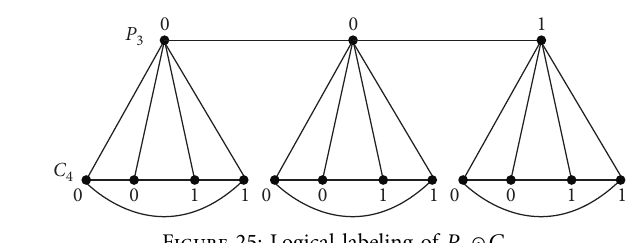
Figure 25: Logical labeling of P